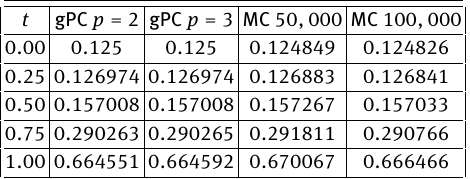
Table 11: Approximation of V [ X ( t )] . Example 4.3, assuming independent random data.